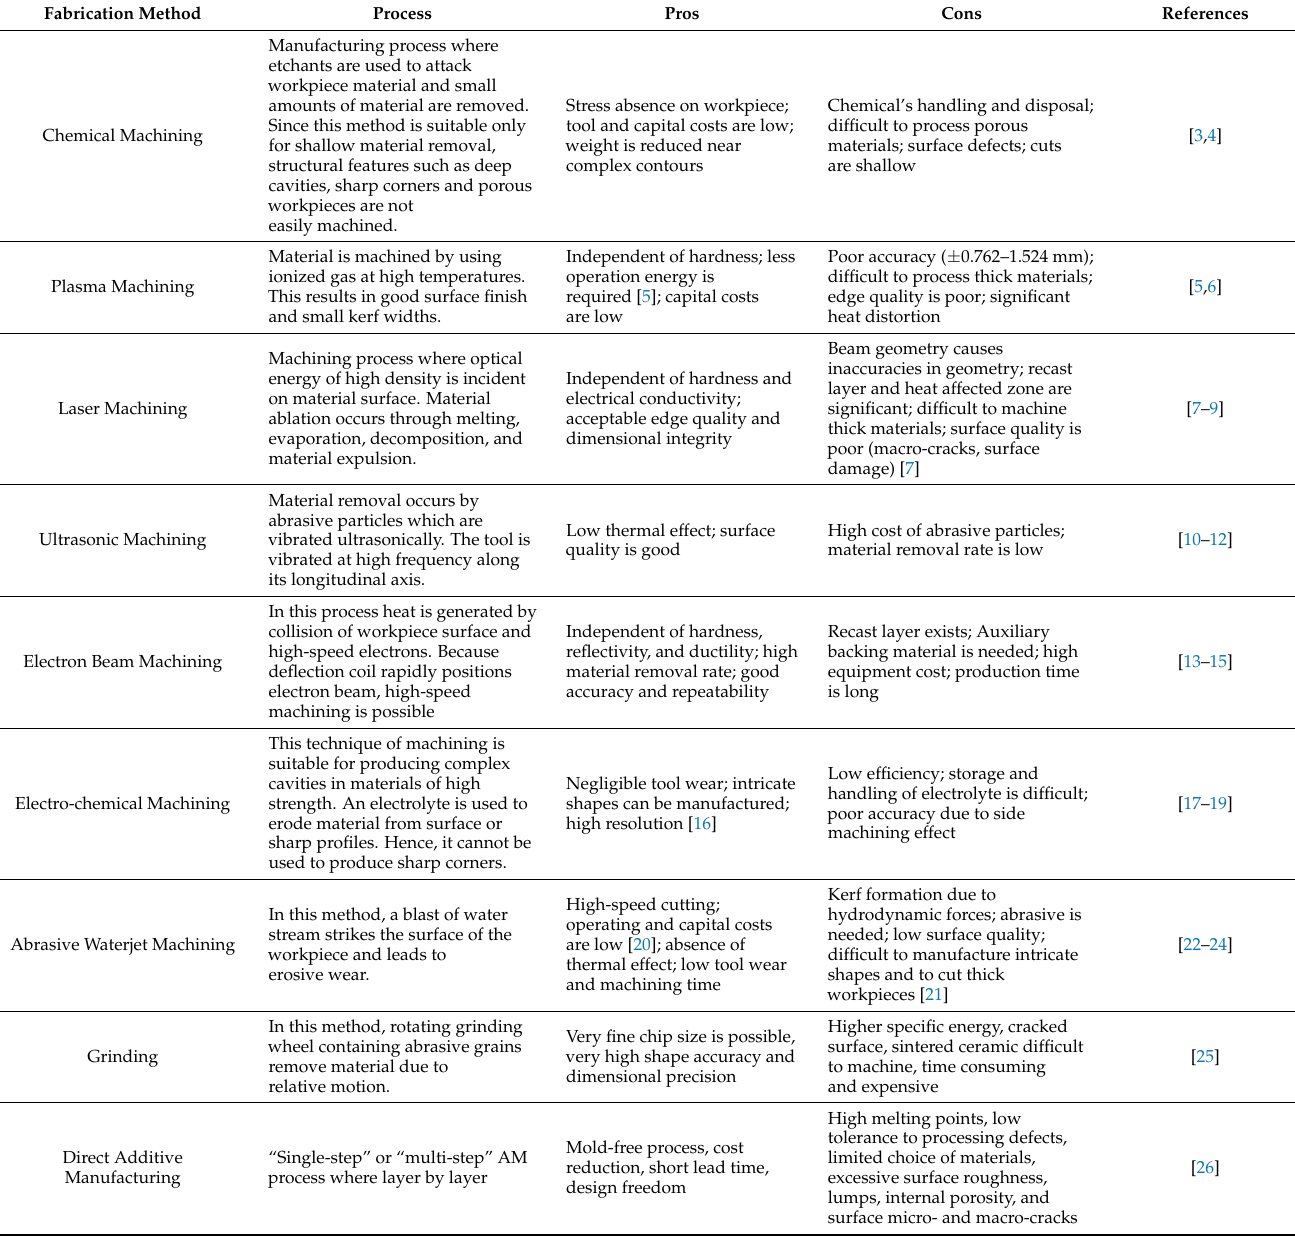
Table 1. Summary of ceramics fabrication